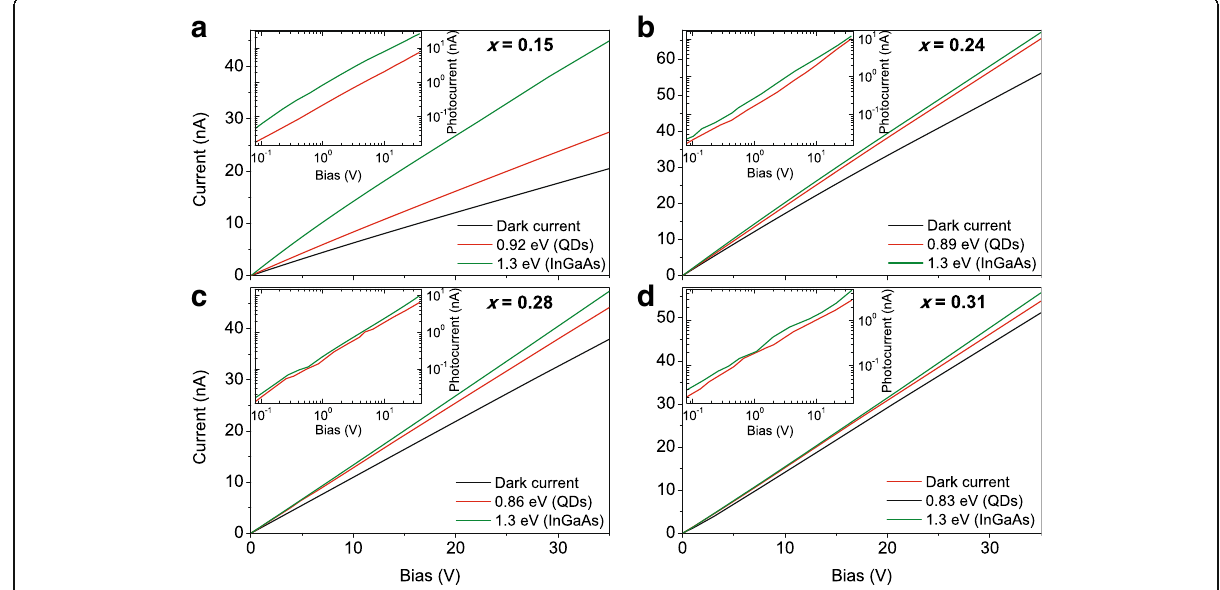
Fig. 2 Color online. I – V characteristics of the InAs/In x Ga 1 − x As structures with x = 0.15 ( a ), 0.24 ( b ), 0.28 ( c ), and 0.31 ( d ) for the dark (black) and under an illumination of 350 μ W/cm 2 (color) at energies of PL spectrum peak (QD excitation) and 1.3 eV (effective absorption in InGaAs). Insets: photocurrent dependences on bias